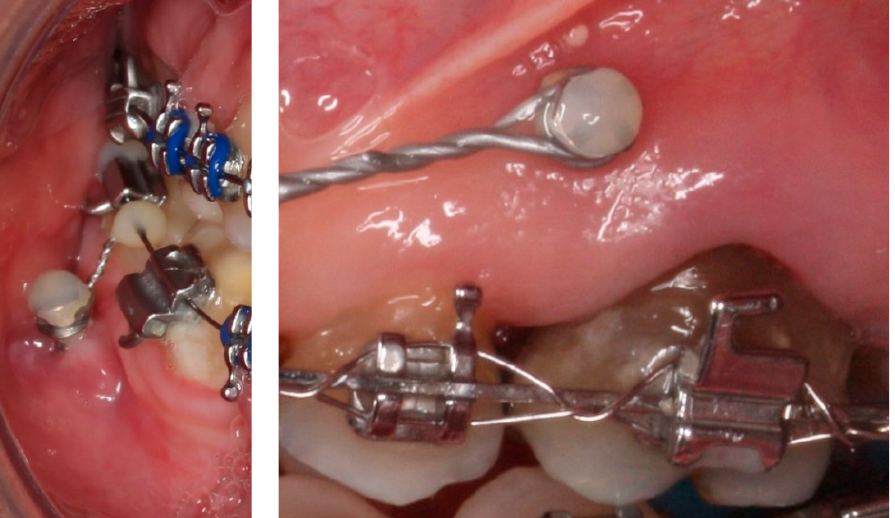
Figure 2. Gingival inflammation around the head of titanium orthodontic mini-implants [5].